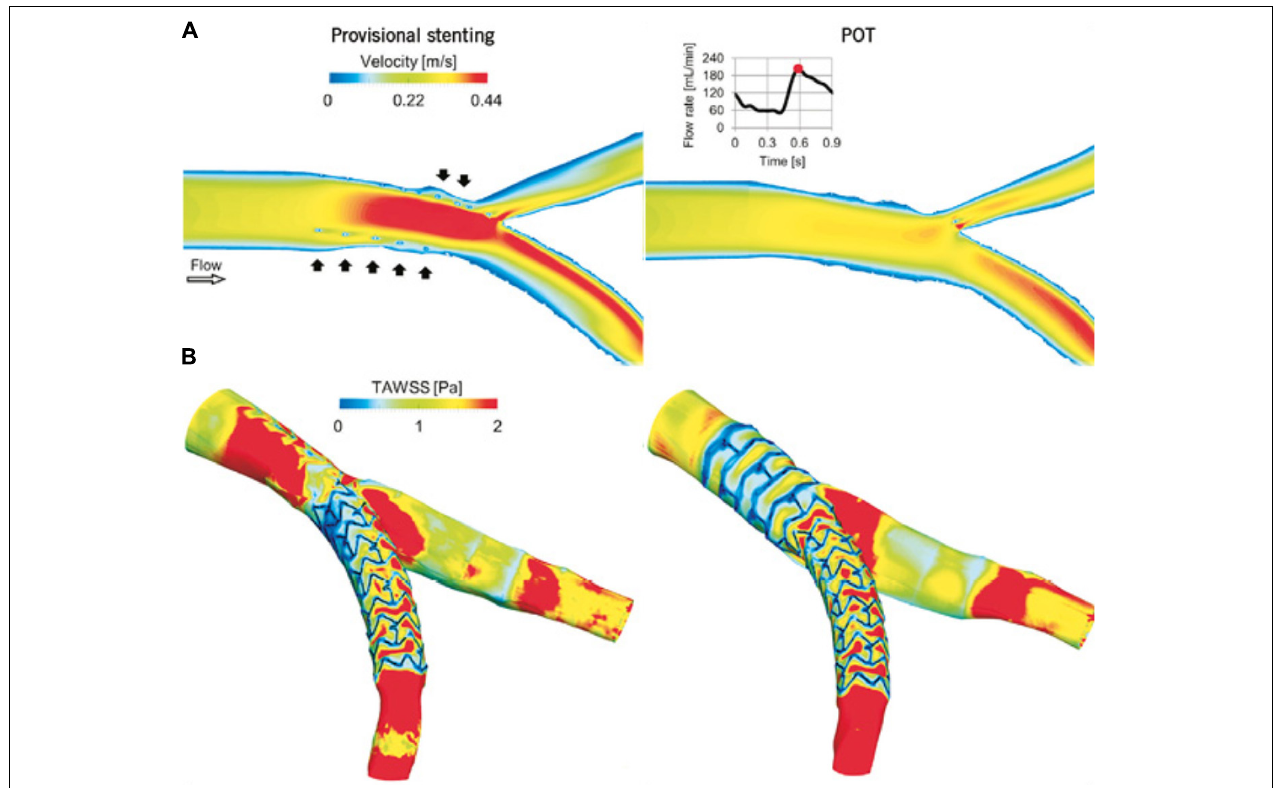
FIGURE 1 | Computational replication of bifurcation stenting. Mortier et al. (2015) compared flow velocity patterns and WSS following virtual provisional stenting (left) and proximal optimization technique (right). (A) Velocity contour maps on an internal plane of the bifurcation at peak flow rate. In the provisional stenting, where the malapposed struts are clearly visible (black arrows), higher velocities are present as the stent behaves as a cylindrical hurdle in the flow stream. Indeed, in the proximal optimization technique (POT), struts are well opposed to the wall and do not obstruct the blood stream. (B) Time-averaged WSS (TAWSS) contour maps. Low WSS are generated next to the stent struts. A wide area with low WSS is present in the bifurcation region in the provisional stenting model and in the proximal part of the stent in the POT model. Reprinted from Mortier et al. (2015). Copyright (2015), with permission from Europa Digital &